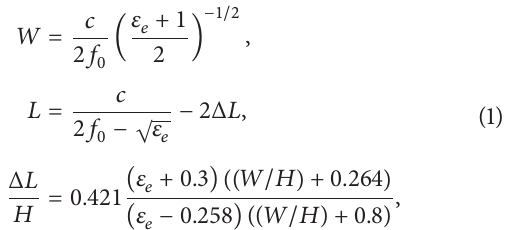
Figure 2: Simulated 𝑆 11 as a function of 𝑑 2 . are 𝜀 𝑟 = 4.4 and tan 𝛿 = 0.02 . The patch antenna is square and has a size of 26.7 × 26.7 mm 2 . There is a pair of bilateral symmetrical T-shaped spiral slots etched on the patch surface. As Figure 1 shows, the lengths and widths of the slots are denoted by 𝐿 2 , 𝐿 3 , 𝐿 4 , 𝑑 3 , and 𝑑 4 and 𝑤 1 and 𝑤 2 , respectively, and the distance between the slots and the patch’s edge is denoted by 𝑑 1 . This antenna is excited by a coaxial cable with a 50 Ω SMA connector. It has a radius of 𝑅 = 0.6 mm and is located at a distance of 𝑑 2 away from the patch center.